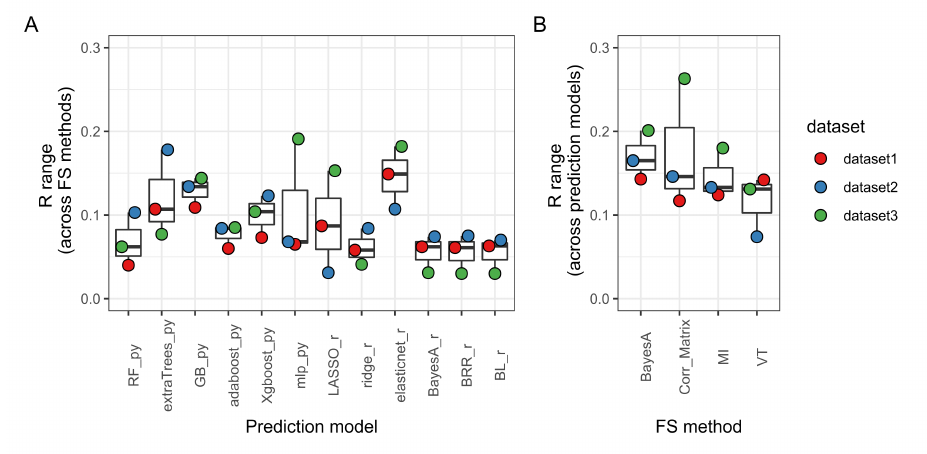
Figure 3. Variation in model performance depends more on the prediction method than on the FS method. ( A ) Range of R values per dataset per prediction model (i.e., across FS methods). ( B ) Range of R values per dataset per FS method (i.e., across prediction